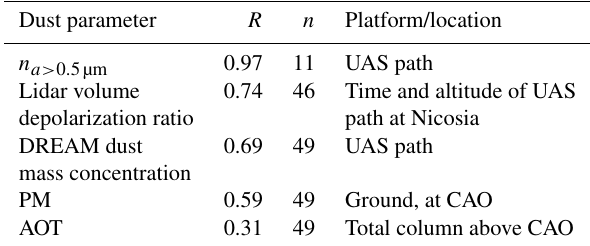
Figure 4. Frequency of trajectories arriving at the UAS airfield (black circle) during the campaign. Back trajectories (10 days) were computed with HYSPLIT (NOAA-ARL, GDAS1, start height 1000m; Stein et al., 2015; Rolph, 2016). Three back trajec- tories (faint blue lines) were initiated for each day of the campaign (03:00, 06:00, 09:00UTC). More than 5% of the trajectories touch the area that lies inside the light pink lines, more than 10% that in- side the dark pink lines, and more than 20% that inside the purple line (based on a 5 ◦ by 5 ◦ grid size). Table 2. Correlation coefficients of INP concentration sampled from UASs ( T =− 30 ◦ C; RH ice = 135.4%) to dust-related param- eters.